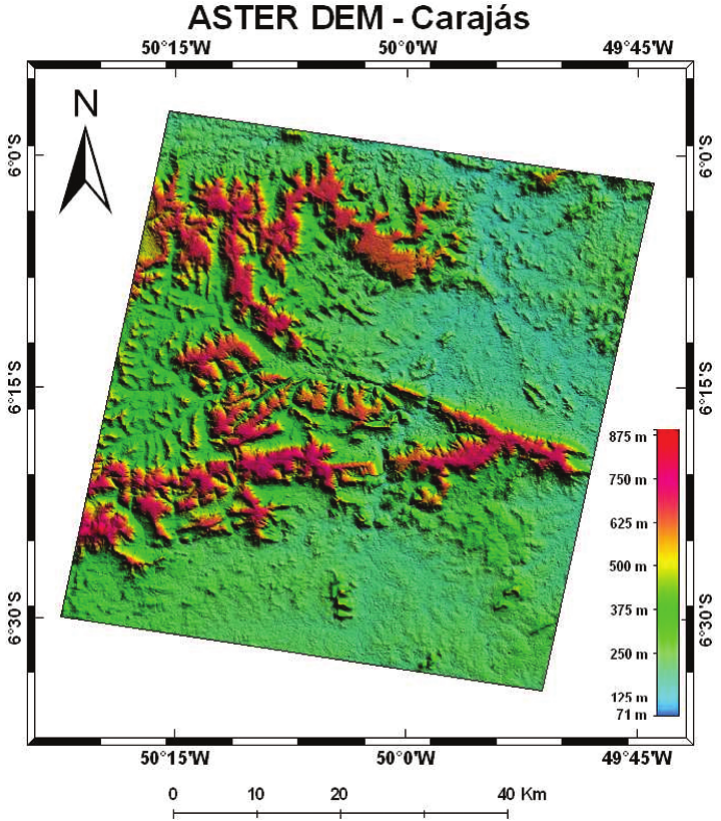
Fig. 5 – Best ASTER DEM using a combination of 28 GCPs and 20